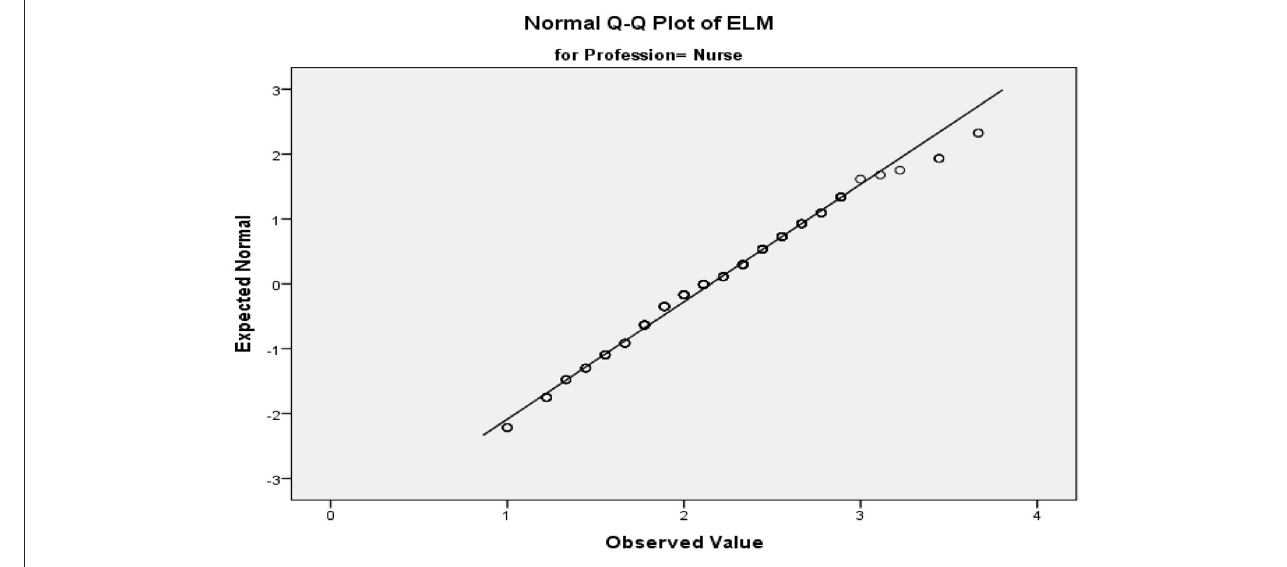
FIGURE 3 | Normality plot of JPM.